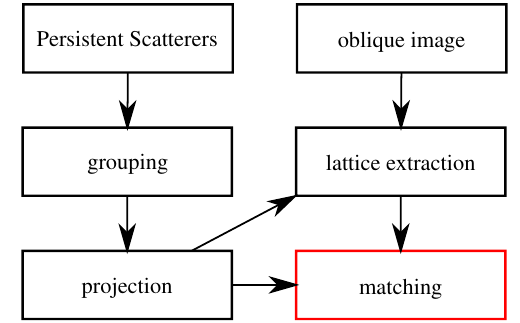
Figure 2: Flowchart of the overall processing chain. The lattice extraction in optical data is assisted by the projected grouping results of PS. The matching step is in the focus of this paper and is done in the image